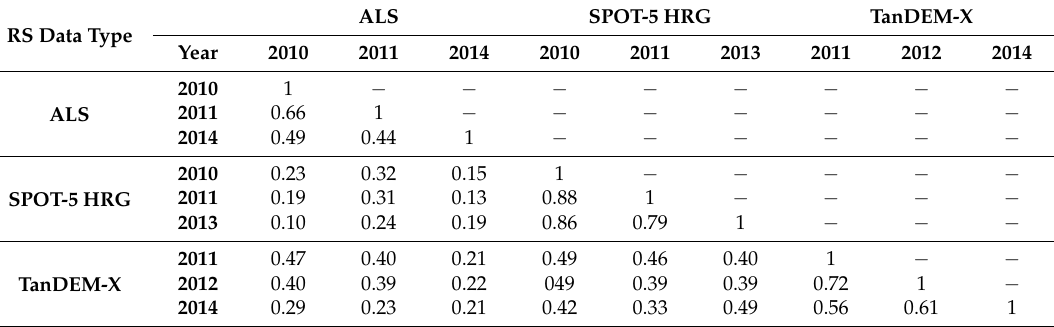
Table C2. Residual correlations between and within three different RS data types in estimating mean